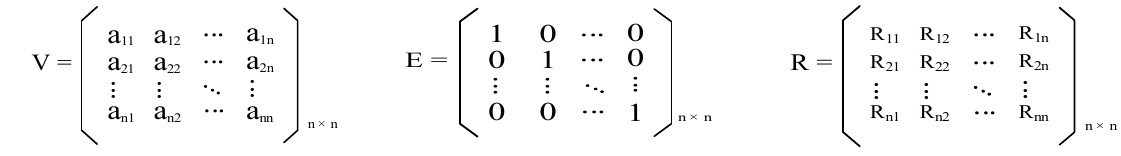
Figure 3. The matrixes V, E, and R.